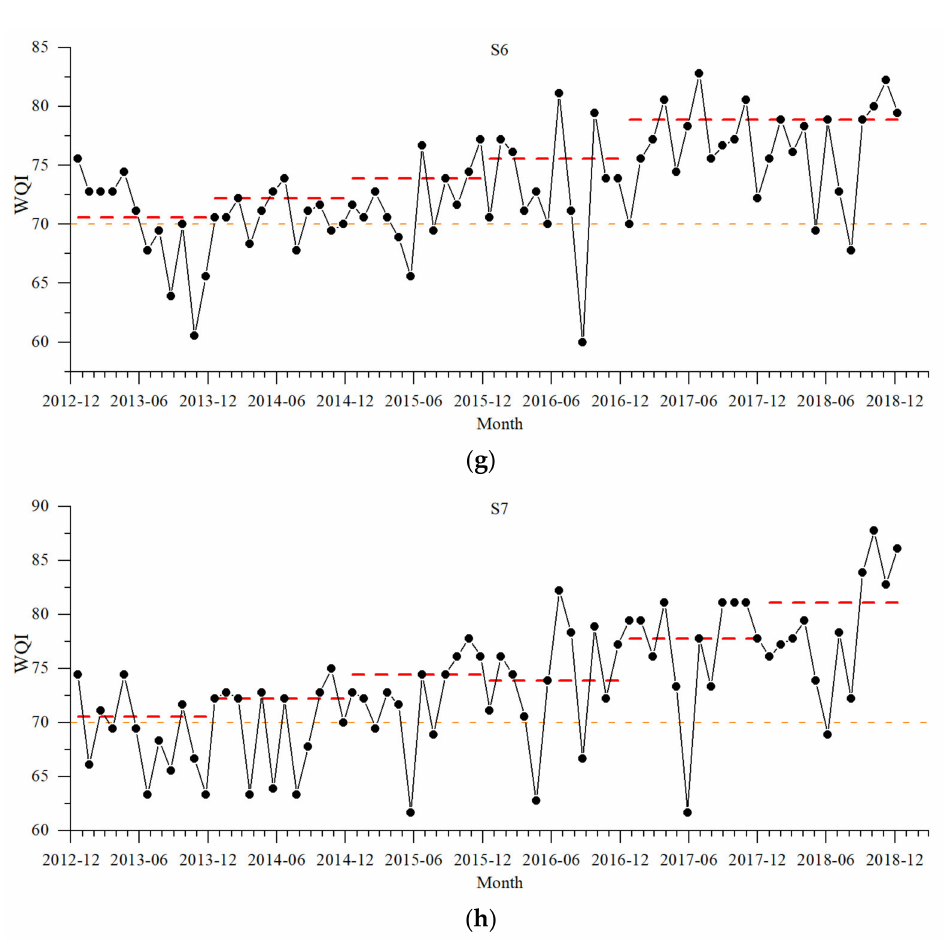
Figure 5. Monthly WQIs and annual WQIs of each site from 2013 to